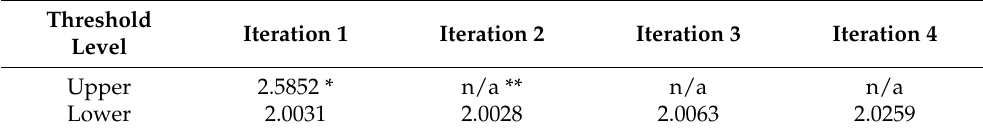
Table 1. LSDL decomposition results for Dataset 1.